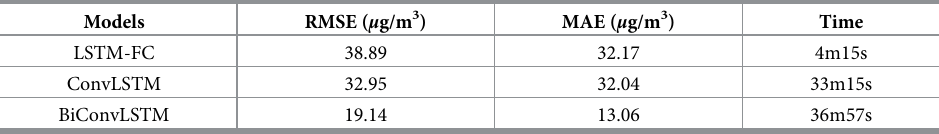
Table 5. Prediction errors (RMSE, MAE) and runtime of the models for the next 6 hours prediction implemented on all features.